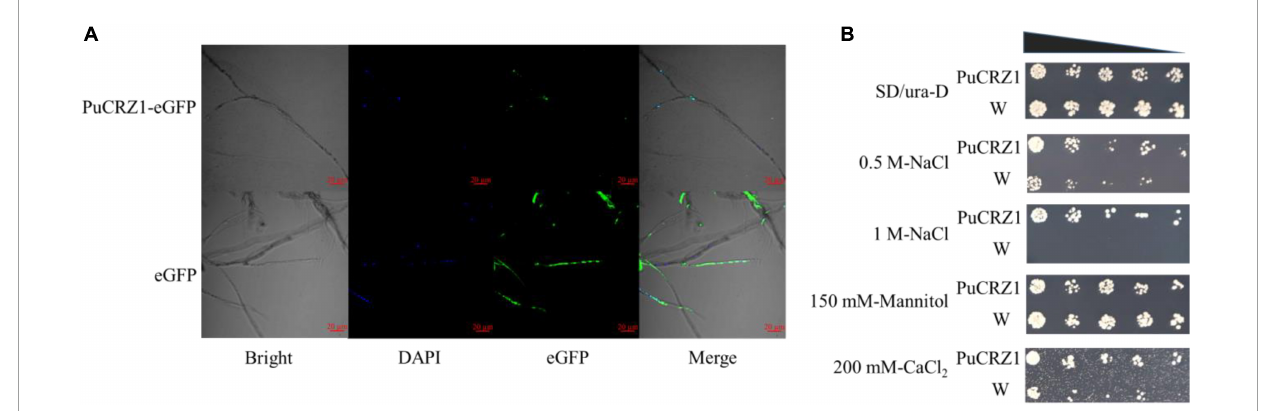
FIGURE2 Sublocation and function of PuCRZ1 . (A) Subcellular localization of PuCRZ1 in P. umbellatus mycelia. PuCRZ1 -eGFP fusion proteins localized to the nucleus in P. umbellatus mycelia. Nuclear marker is DAPI. Bar = 20 µ m. (B) PuCRZ1 gene could reduce the sensitivity of NaCl and CaCl 2 in yeast cells. S. cerevisiae was transformed with either an empty pYES2 (W) or the pYES2 carrying the cDNA of PuCRZ1 (PuCRZ1). After obtaining the transformed yeast strains, they were cultured in SD/-Ura liquid medium to OD 600 = 1.0, and then diluted 100, 1000, 2000, 5000, 10000 times with SD/-Ura liquid medium with D-galactose.